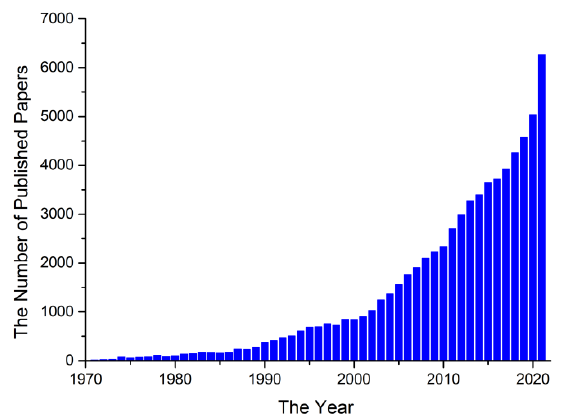
Figure 1. Statistics of research papers related to hypergraphs from 1970 to 2021.